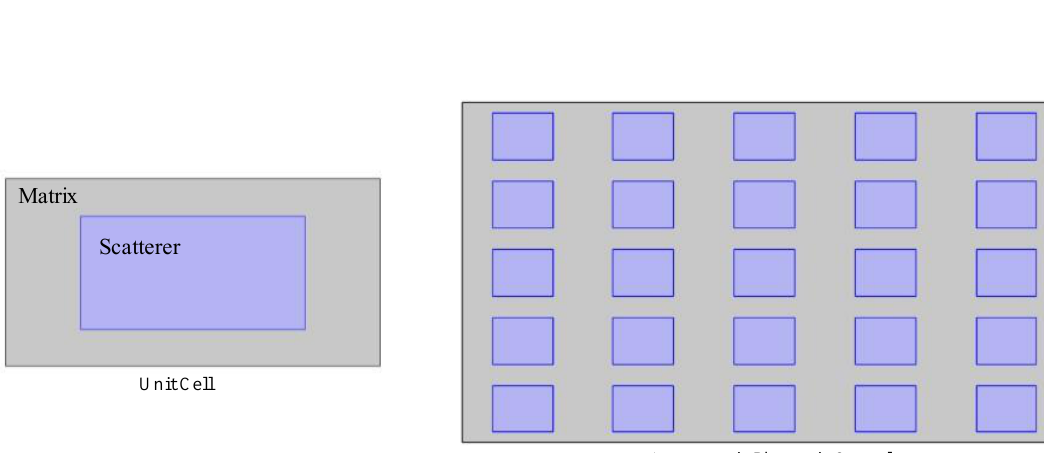
343 | Vol. 7, No. 3, 2022